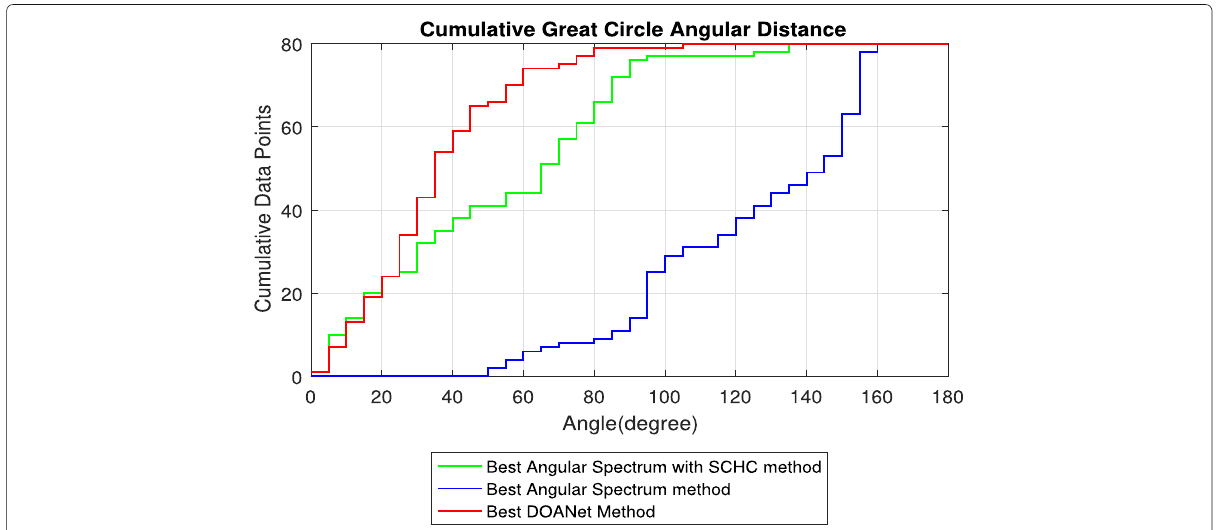
Fig. 13 AUCs for cumulative in-flight great-circle angular distance